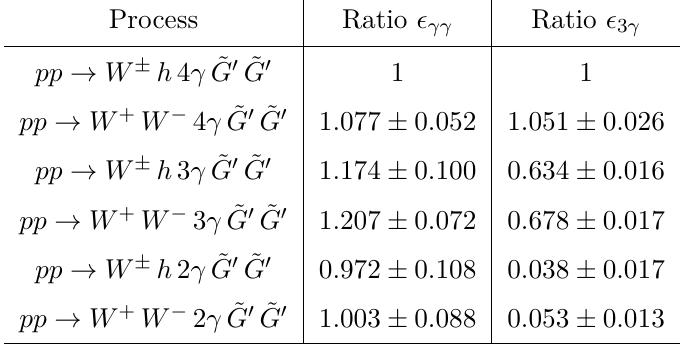
Table 5 . Average ratio of efficiencies for each process with respect to the main process (4.1) (first line) for SR γγ and SR 3 γ . The uncertainties are the standard deviations of the ratios across the five grid points from which the averages have been